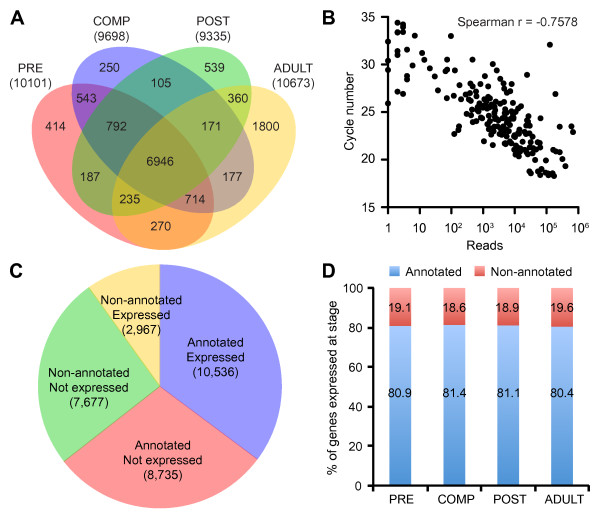
Identification of expressed genes. (A) Stage distribution of transcripts detected above the cutoff threshold of 64 reads. The total number of transcripts detected at each stage is in parentheses. PRE, precompetent; COMP, competent; POST, postlarvae; ADULT, adult stage. (B) Comparison of sequencing read counts and quantitative RT-PCR cycles for 50 selected transcripts in the four developmental stages. (C) The number of annotated versus non-annotated genes detected by sequencing. Gene annotations are based on alignment to known sequences in the UniProt database (e-value ≤ 1x10-4). Non-annotated genes have no significant matches in UniProt and may include potential ‘sponge-specific’ genes. Only 28% of non-annotated genes were found to be expressed compared to 55% of annotated genes. (D) Similar percentages of annotated and non-annotated sponge genes are expressed at each developmental stage.